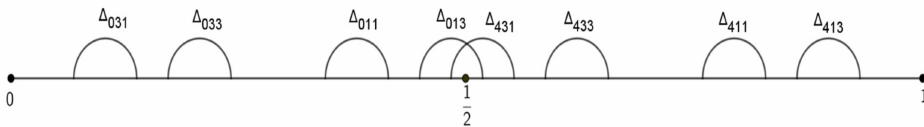
Figure 14. The image of the plural C 5 : G-cylinders of the 3rd